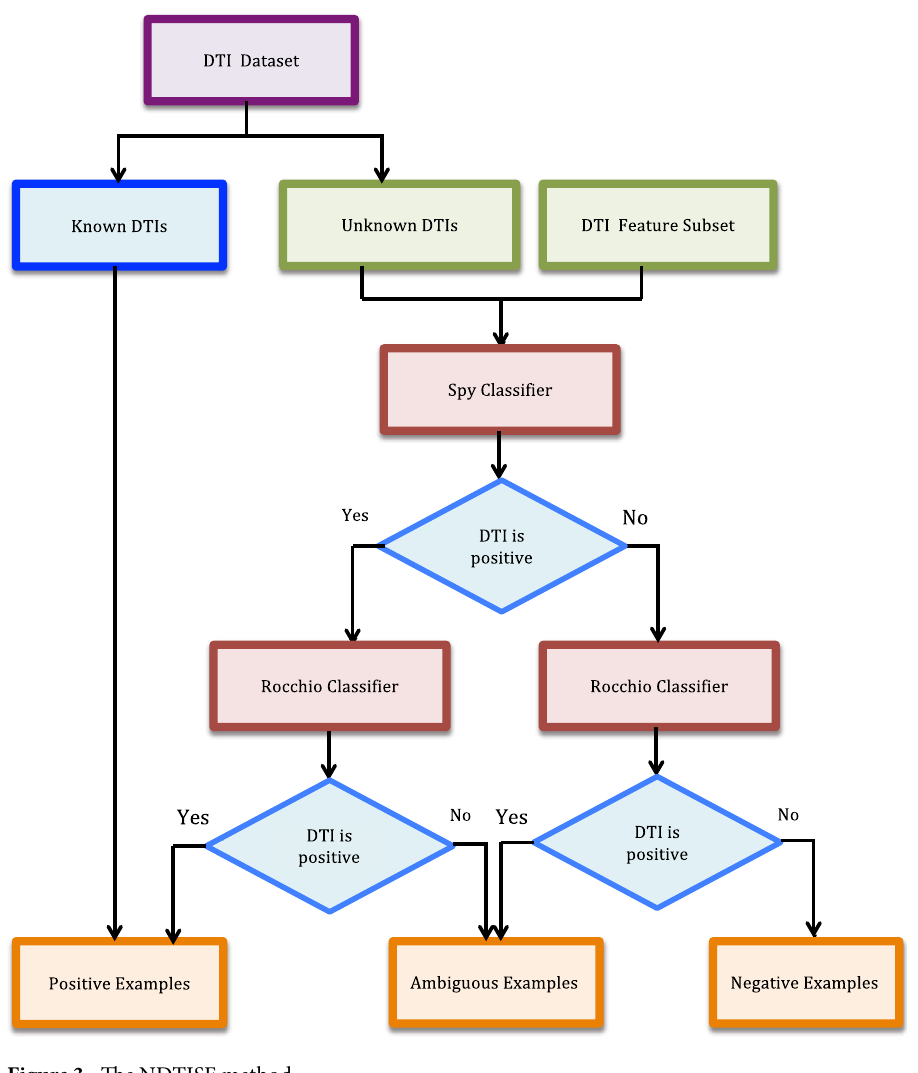
Figure 3. The NDTISE